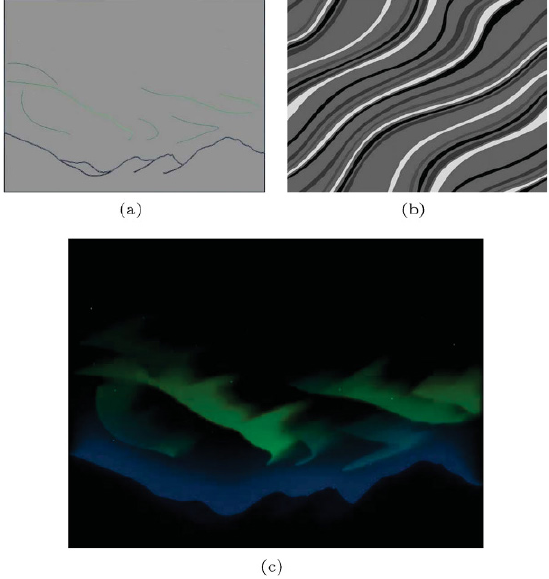
Fig. 13 Gray images used as strength coefficient layers. Using the color layer in (a), and strength and direction coefficient layers as in Fig. 2(a), one further strength coefficient layer, given by the gray image in (b), is added to the DCC model, resulting in a more realistic aurora image in (c).